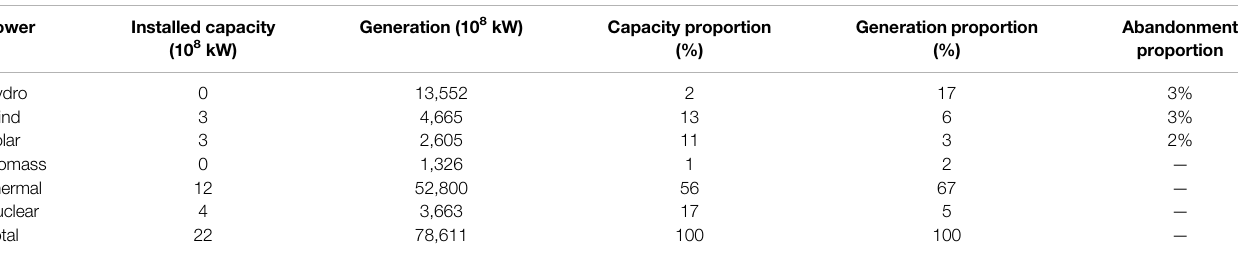
TABLE 1 | China ’ s power generation in